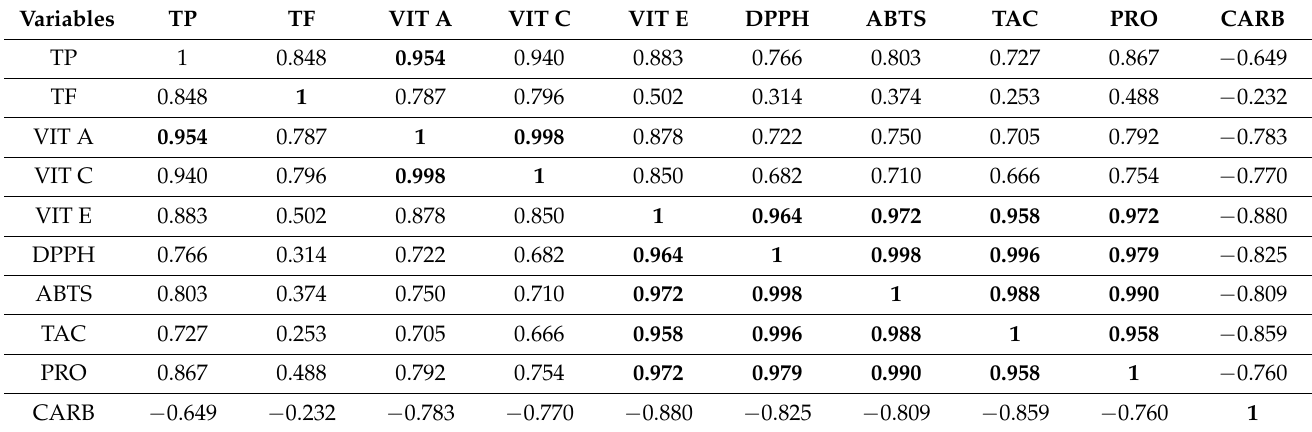
Table 3. Pearson’s correlations (r) between total phenols (TP), total flavonoids (TF), vitamin